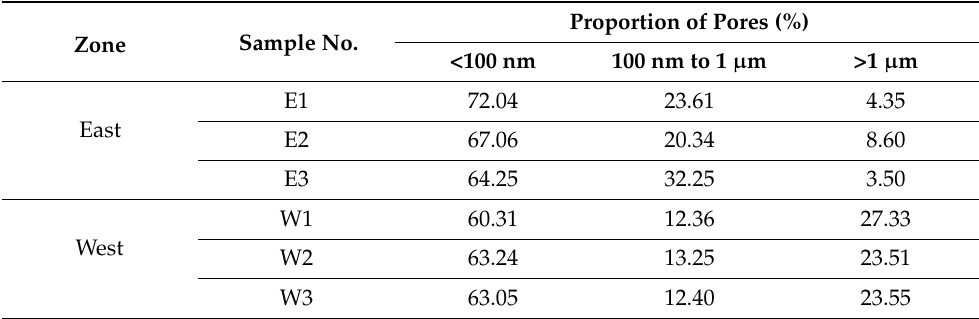
Table 3. The proportion of pores with different diameters of the No.5 coal seam of 16 CBM wells in the Weibei Field.